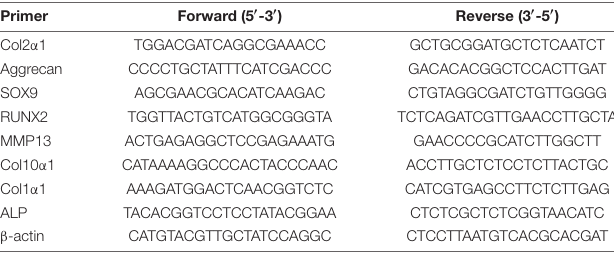
TABLE 1 | Primers names and sequences. Primer